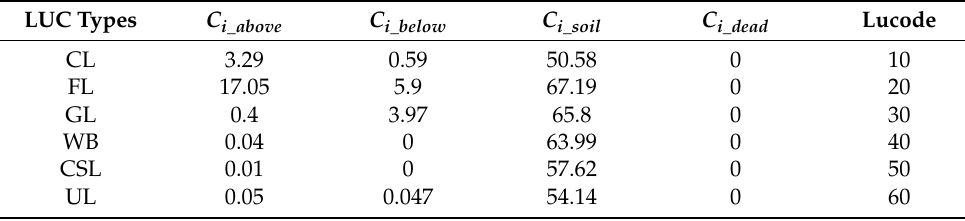
Table 5. Carbon density for different LUC